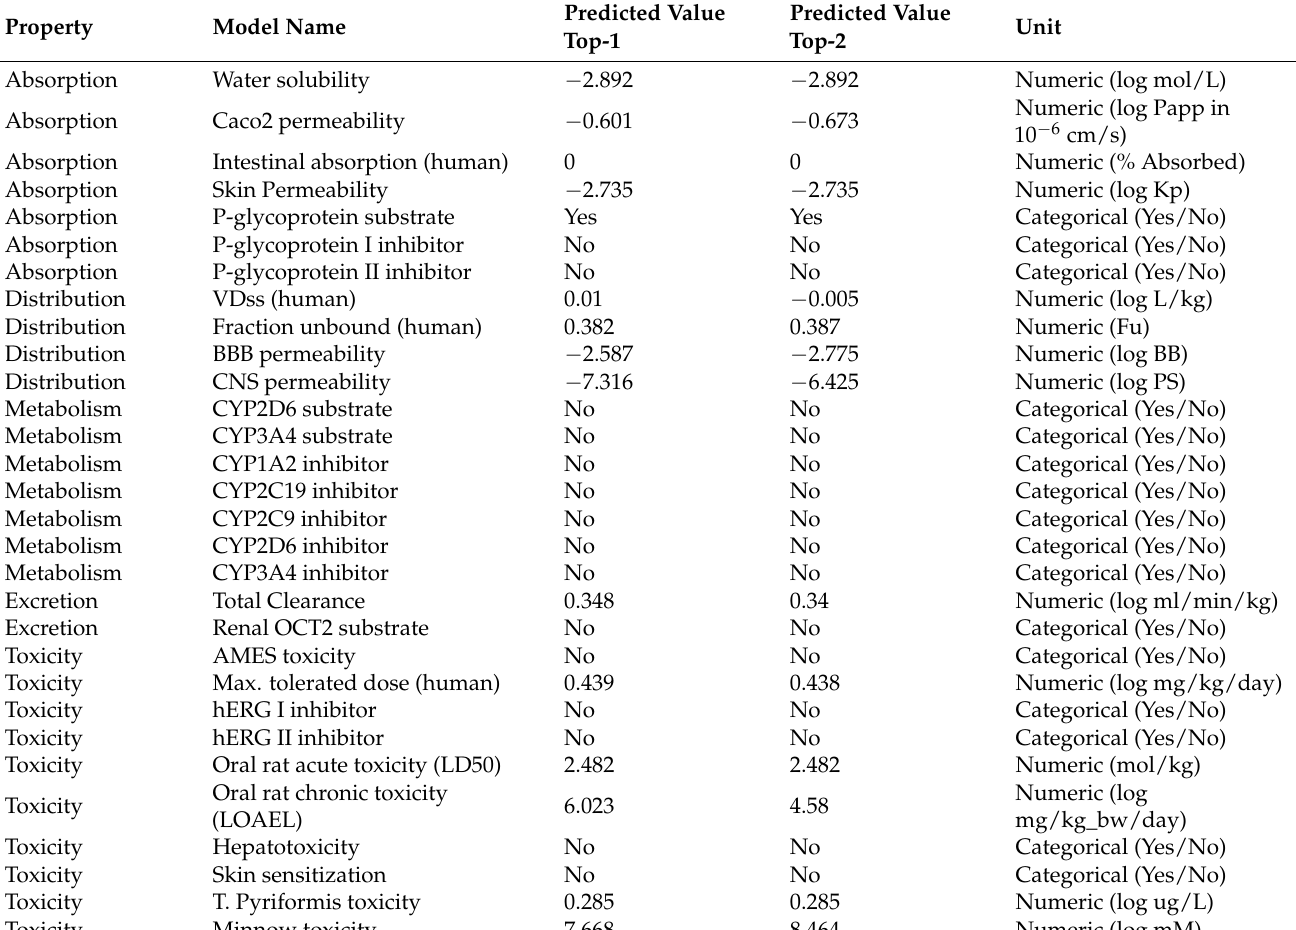
Table 5. Detailed pharmacokinetic data of lead